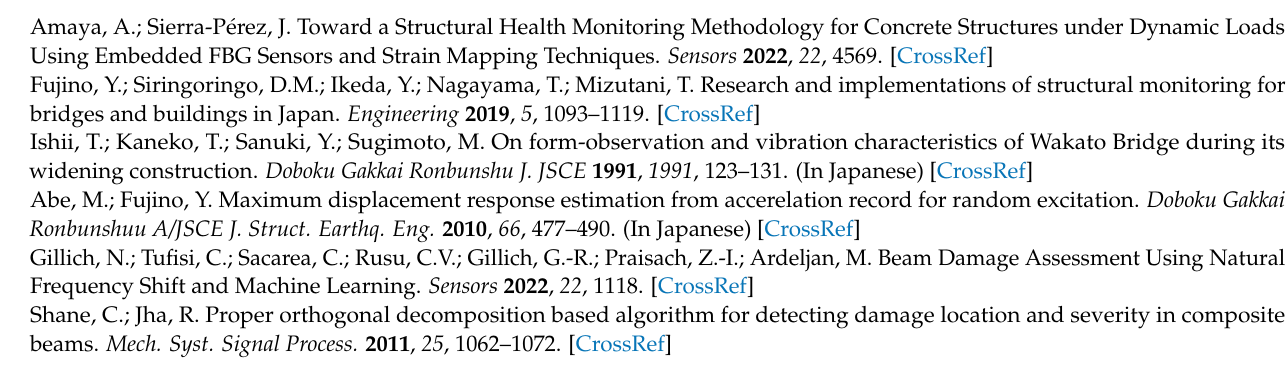
Figure A14. The application results of the PRE method in the case of Scenario 12 (stiffness decrease section: 6𝐿/7 ~ 𝐿 , decrease rate: 60%).